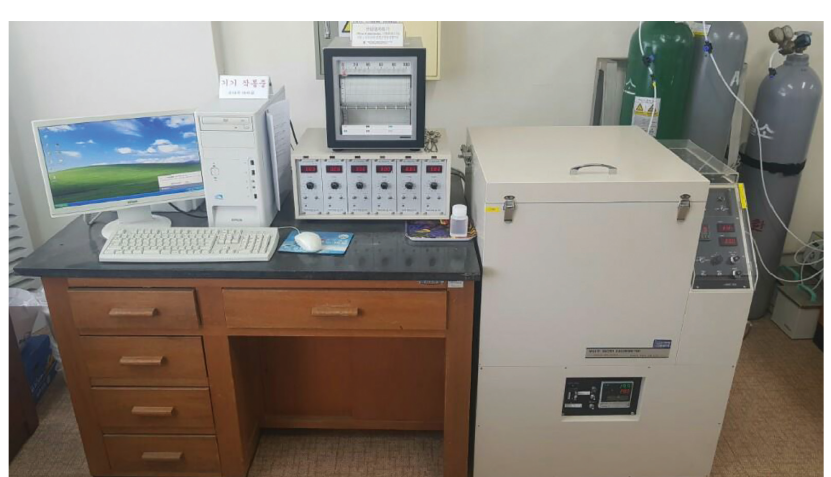
Figure 4: Multi-microcalorimeter.